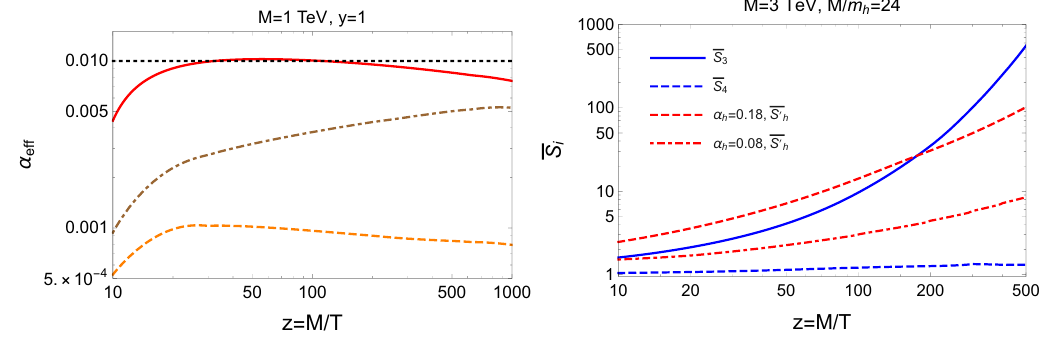
Figure 5 . Right plot: (cid:11) e(cid:11) is given for z = [10 ; 10 3 ] for di(cid:11)erent combinations of the couplings, namely (cid:21) 3 = (cid:25); (cid:21) 2 (2 M ) = 0 (solid red line), (cid:21) 3 (2 M ) = (cid:25)= 2 ; (cid:21) 2 (2 M ) = 0 (dotted-dashed brown line), (cid:21) 3 (2 M ) = (cid:25)= 2 ; (cid:21) 2 (2 M ) = (cid:25)= 2 (dashed orange line). Left plot: generalized